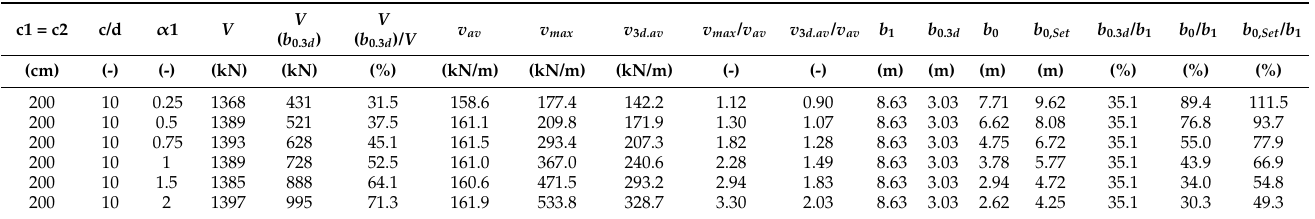
Table A7. Analysis of the shear force distribution in the control perimeter 0.5 d with 200 cm shear cap size.